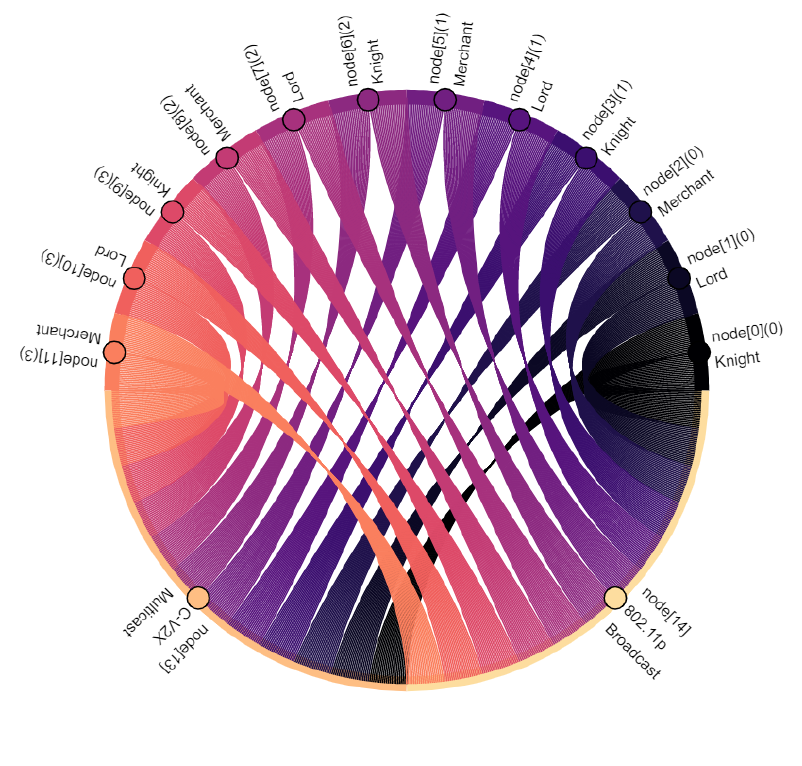
Figure 14. All vehicles broadcast their CAM messages using ad hoc network. The same message is sent redundantly to all vehicles of the platoon